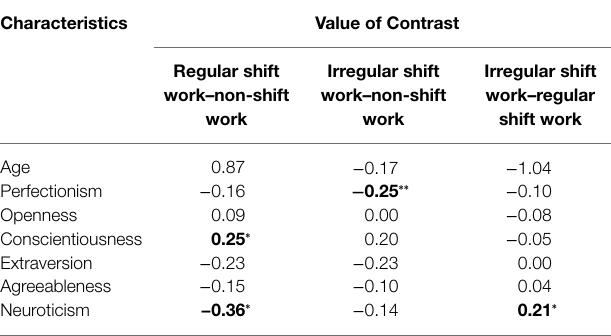
TABLE 2 | ANOVA contrast tests between non-shift workers, regular shift workers, and irregular shift workers.